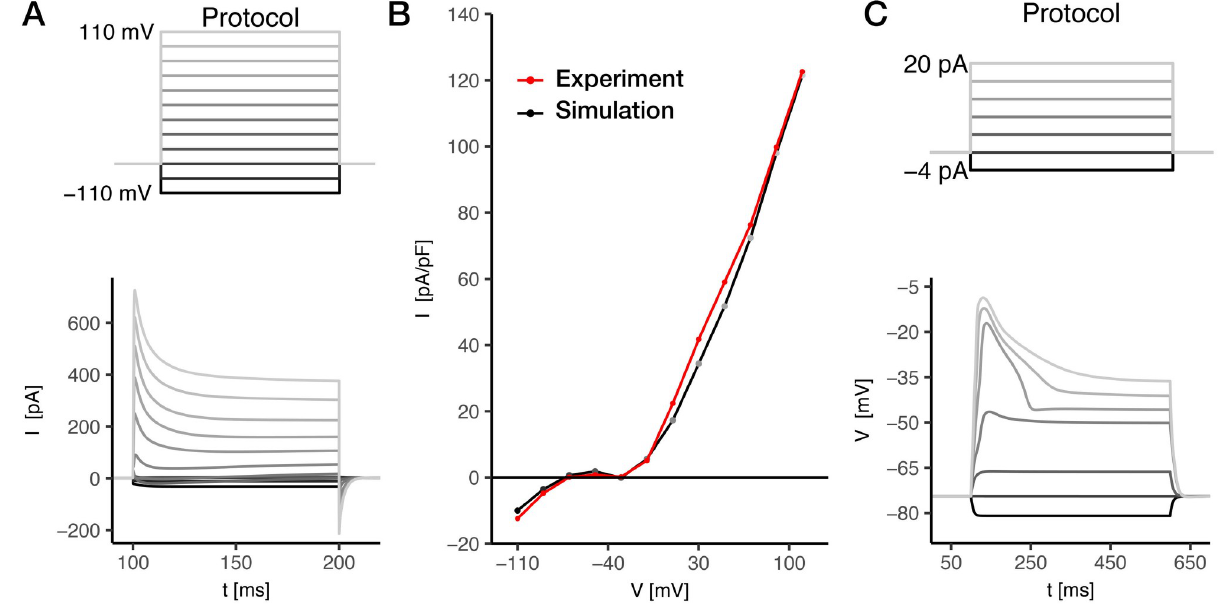
Fig 4. AWC ON response to current and voltage stimuli. A) Voltage clamp simulation of the AWC ON neuron . Experimental data from [59]. To test the model we apply to the in silico neuron the same voltage clamp stimulation protocol of experimental whole-cell recordings [59]. The protocol consists in voltage steps ranging between -110 mV and +110 mV with 20 mV increments. The holding potential is V = − 70 mV, and the step duration h is 100 ms. B) AWC ON steady-state I-V relation . Comparison between experimental (red, data from [59]) and simulated (black) steady-state I-V curves. The simulated I-V curve is computed by averaging the currents in the last 5 ms of each voltage step, as in [59]. C) Current clamp simulation of the AWC ON neuron . No published current clamp experimental data were found for AWC ON . The in silico neuron shows active behavior when the injected current is above 6 pA (S6 Fig). The voltage response is characterized by an upstroke with a duration of � 30 ms for I ext > 15 pA, followed by a plateau phase. The plateau height increases linearly with the stimulus amplitude (S6 Fig). A sensitivity analysis performed by varying the calcium removal rate τ Ca (Eq 28 and S6 Fig) do not show significant changes in the results. Current clamp stimulation protocol consists in 6 current steps ranging from -4 to 20 pA, with a duration of 500 ms. The holding current is I = 0 pA. The cell capacitance is 3.1 pF [59], that corresponds to 1.3 μ F/cm 2 when scaled on the h entire cell surface ( S cell = 238.16 μ m 2 ,from Neuromorpho.org). This value is in agreement with specific membrane capacitance reported for ASER [57], and with the one calculated for AIY by considering its total capacitance ( � 0.7 pF [78]) and surface (65.89 μ m 2 , from